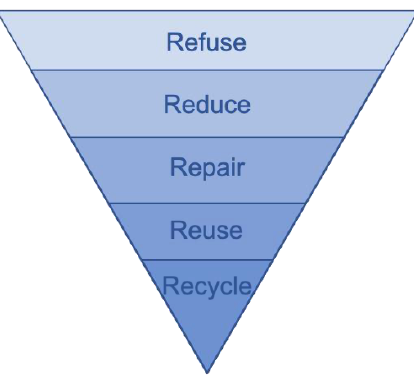
Figure 2: Scheme of 5R principle for construction and buildings (source: